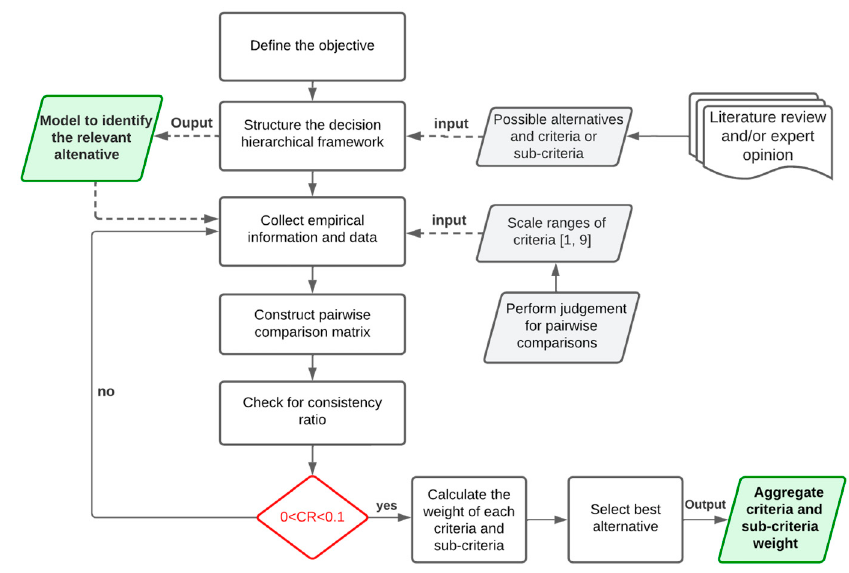
Figure 2. Flowchart of the Analytic Hierarchy Process (AHP) method.